Question: What visual encoding does this figure use to show its data?
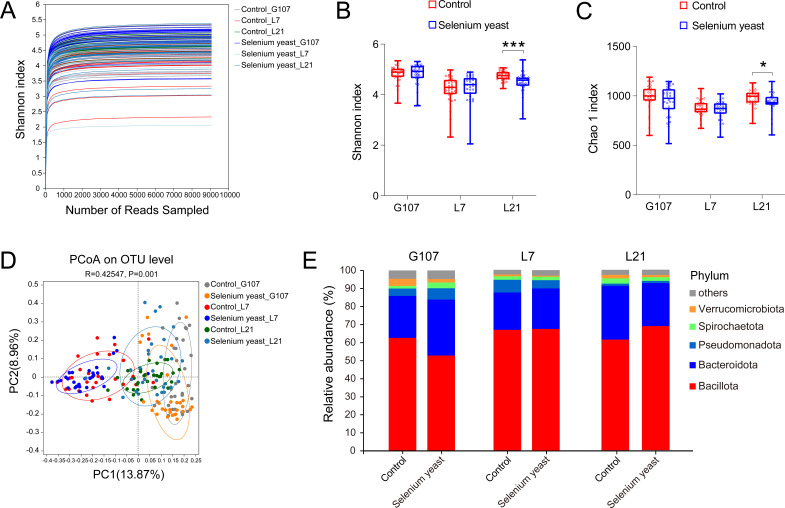
Answer: line